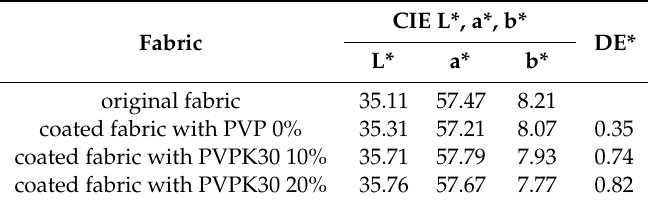
Table 3. Comparison of the color change with di ff erent